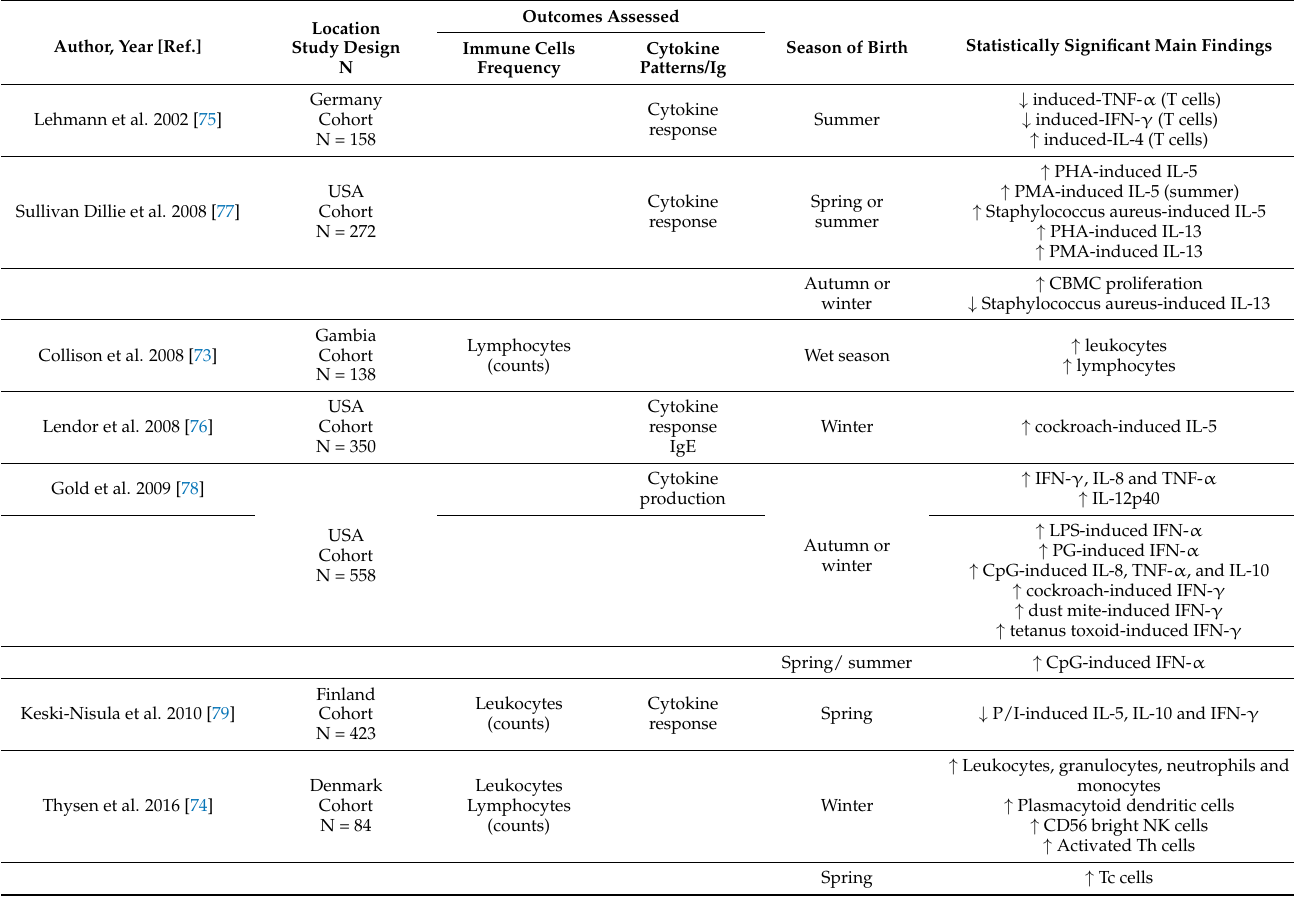
CBMC: cord blood mononuclear cell; CD: cluster of differentiation; CpG: Immunostimulatory CpG oligonucleotides; IFN: interferon; IL: interleukin; LPS: Lipopolysaccharide; NK: natural killer; PHA: Phytohemagglutinin; PMA: phorbol 12-myristate 13-acetate; P/I: phorbol ester and ionomycin PG: Peptidoglycan; Tc: T cytotoxic cells; Th: T helper cell; TNF: tumor necrosis